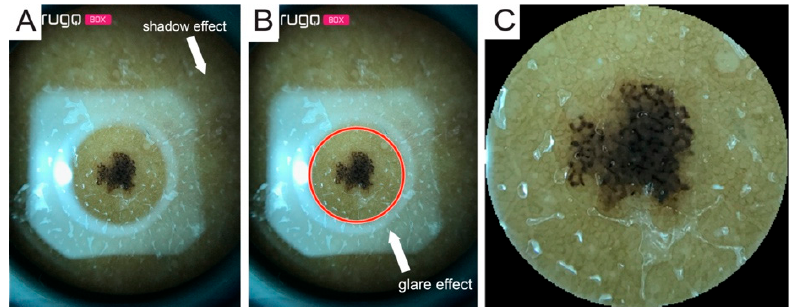
Figure 3. ( A ) Example of original image; ( B ) Example of original image with Hough transform result; ( C ) Cropped image.